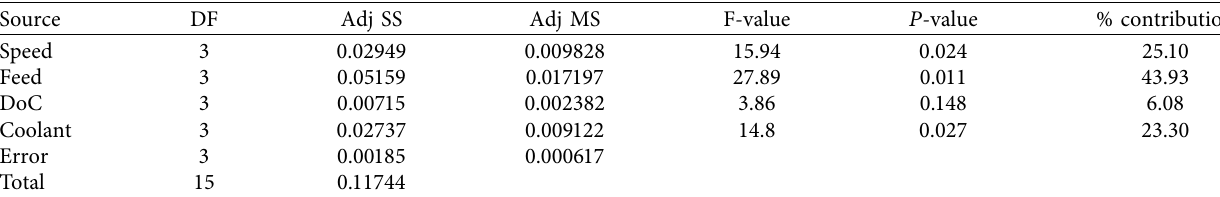
Table 9: ANOVA for CC